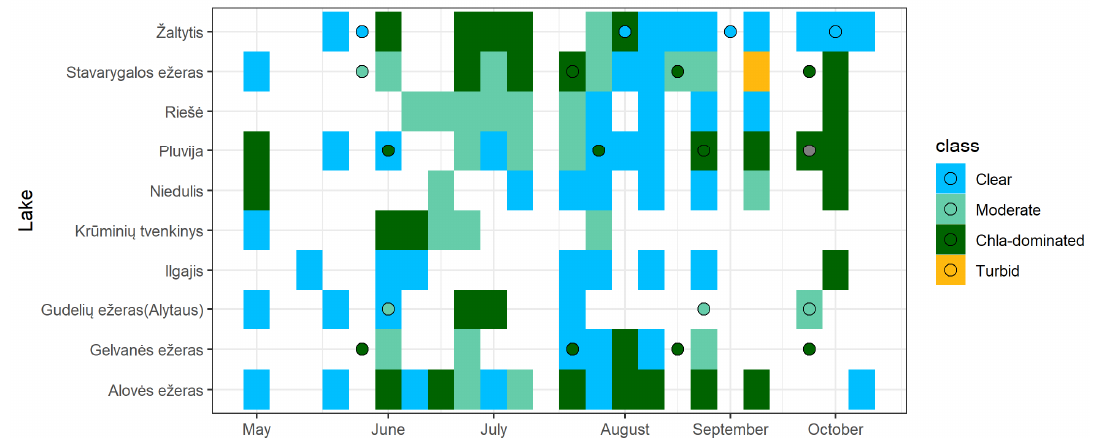
Figure 6. Class changes based on in situ (circles) and model (squares) data in lakes with the prevalent Chla-dominated class in the year of 2020 when Clear or Moderate classes were observed in these lakes. The grey observation of class in lake Pluvija is beyond the definition of four (Clear, Moderate, Chla-dominated, and Turbid) classes used in this study.